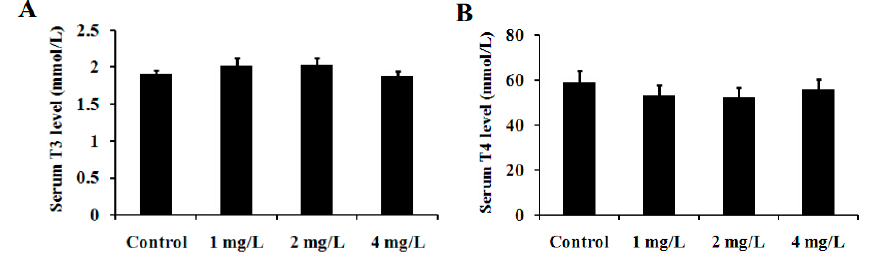
Figure 8. Effect of As exposure on serum concentrations of T3 ( A ) and T4 ( B ) of mice. Adult male mice exposed to 0, 1, 2, and 4 mg/L As 2 O 3 in drinking water for 60 days. After the treatment, the concentrations of T3 and T4 in mice serum were determined by RIA. Data obtained from six separate analyses are expressed as mean ± SD ( n = 6 for each group).